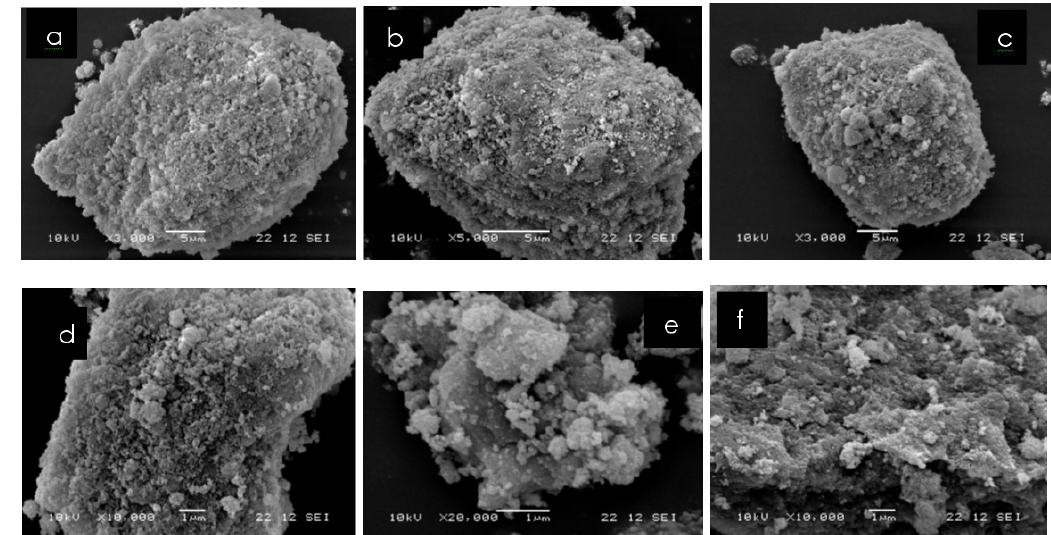
Figure 2. Scanning electron microscope for HAP (a,d), HAP-Si (b,e) and HAP-Si doped with copper (c,f)